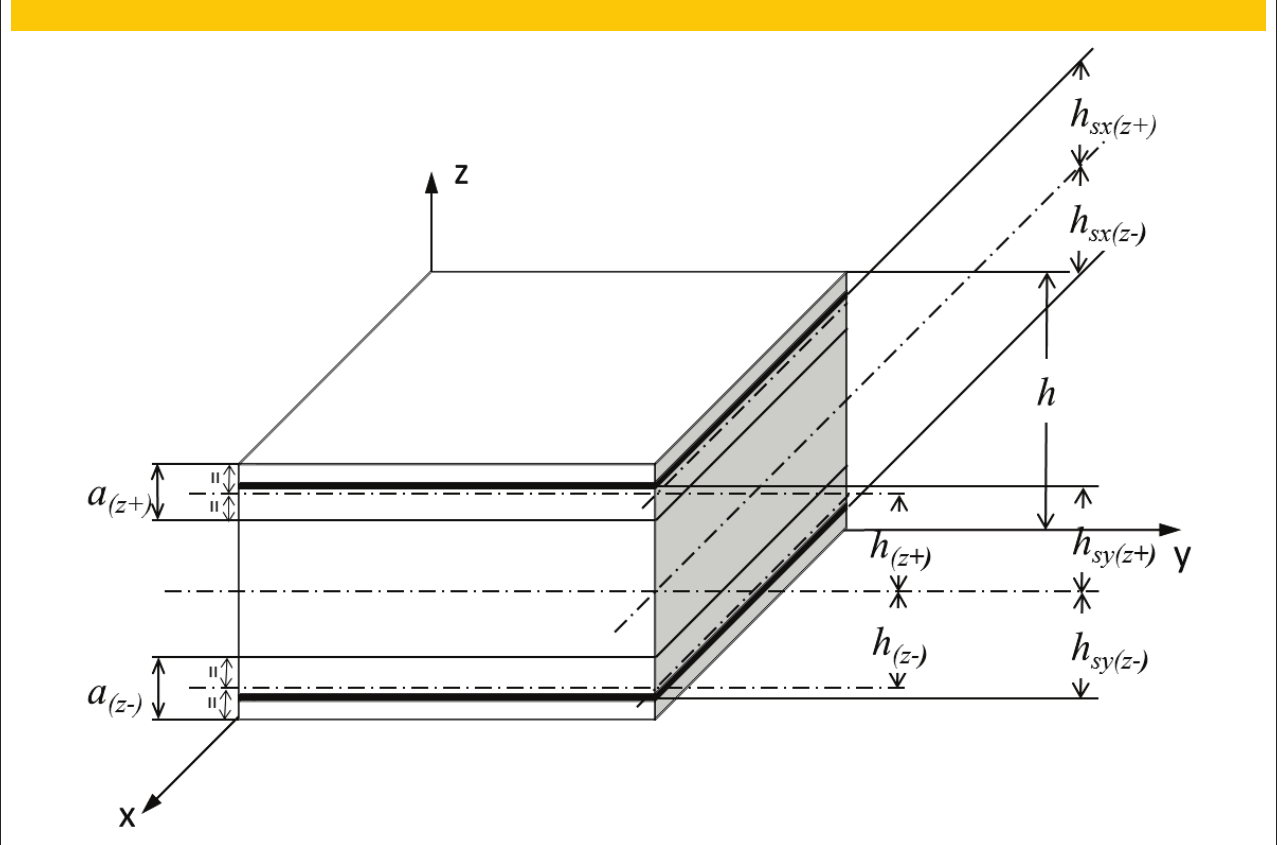
Figure 3 – Dimensions used in the three-layer model